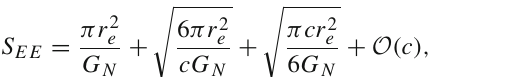
It is straightforward to see that the extremal condition /∂ t = 0 leads to t ∂ S a gen